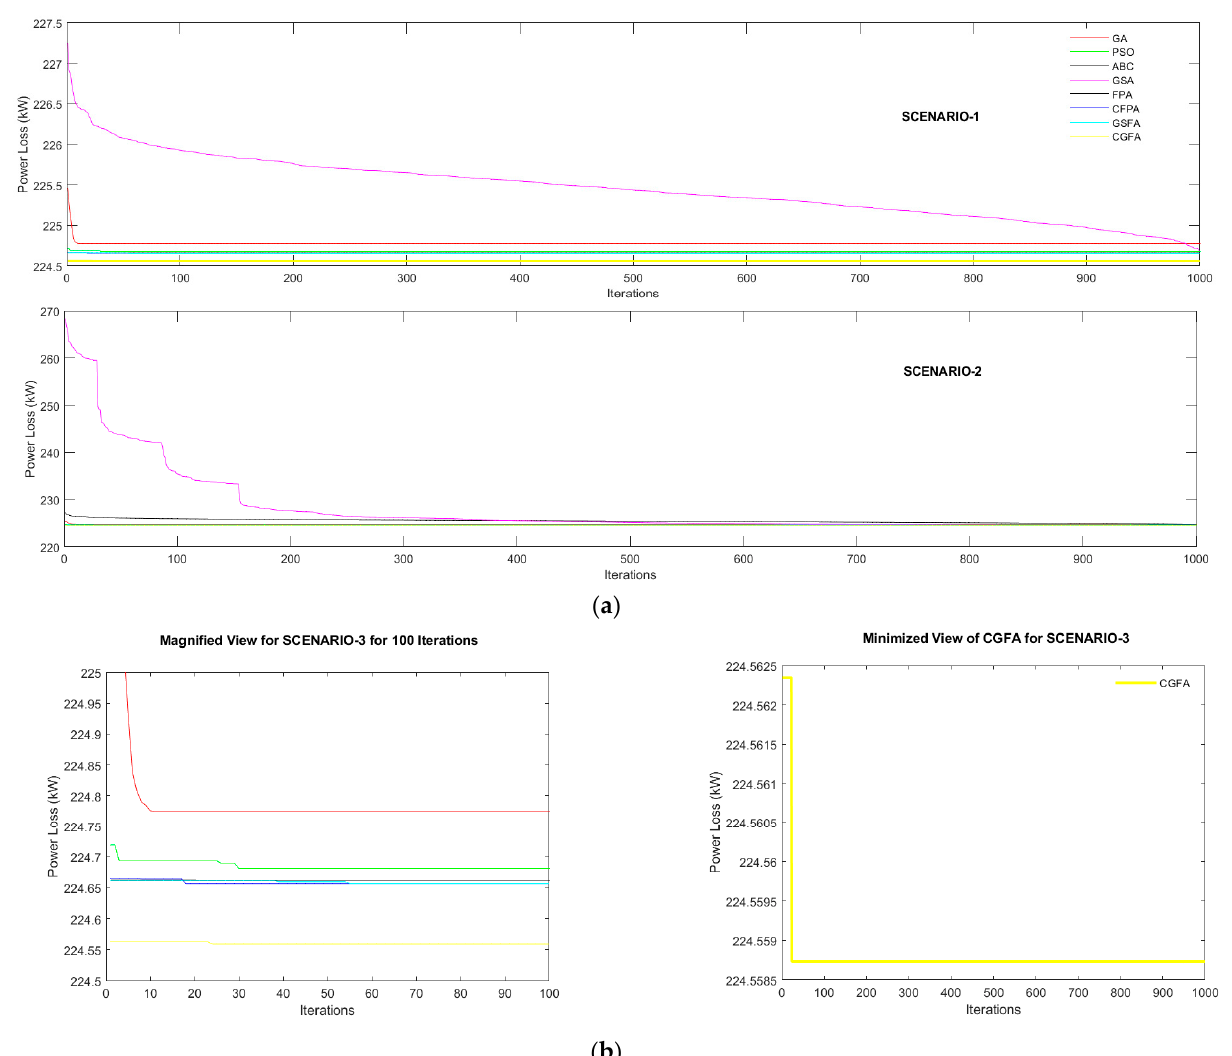
Figure 6. IEEE 69-bus system.